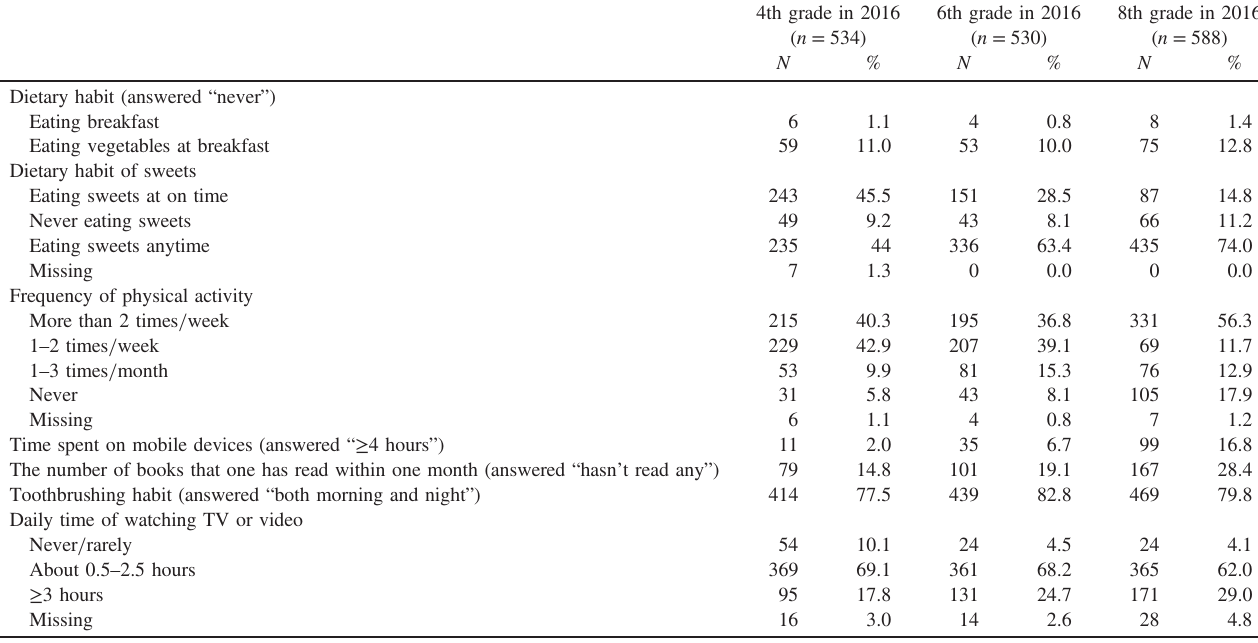
Table 7. Selected pro fi les answered by children for the 2nd wave of A-CHILD